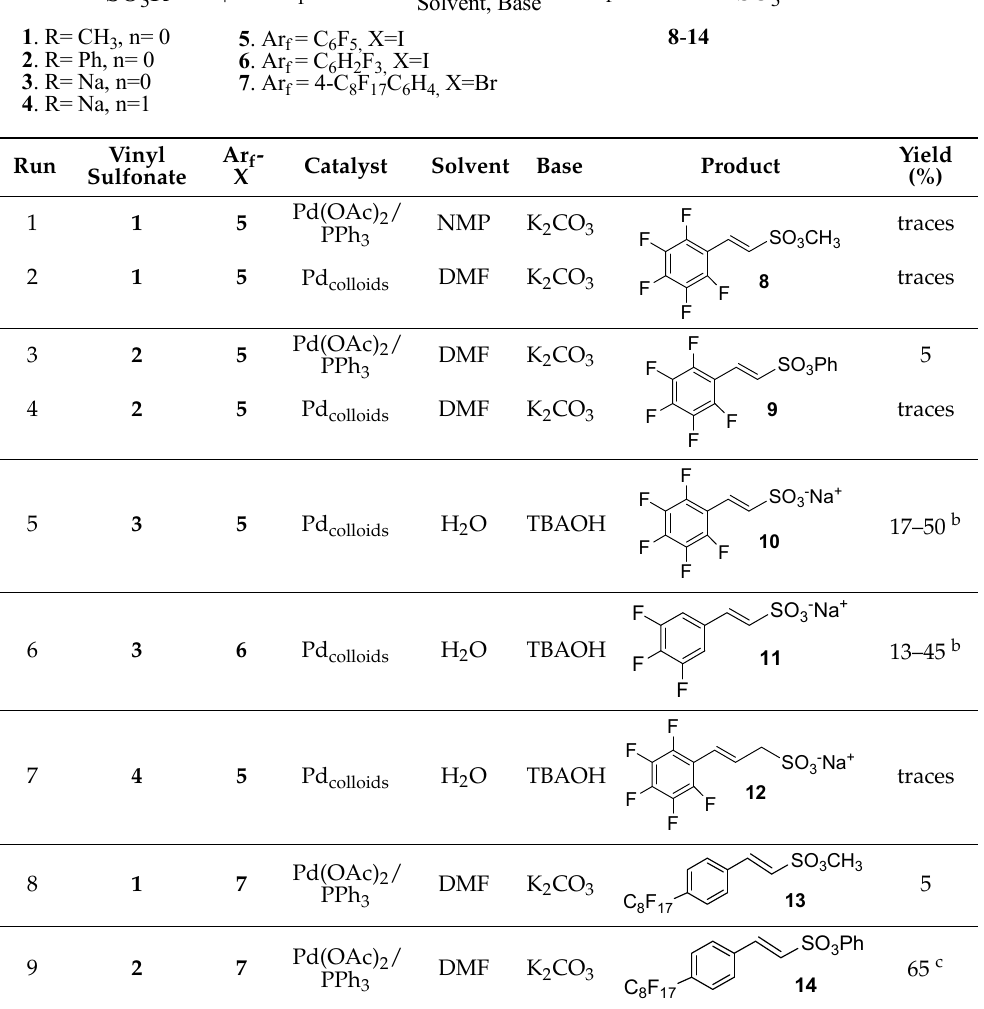
Table 1. Heck-type coupling of unsaturated sulfonates with perfluoroaryl halides a .